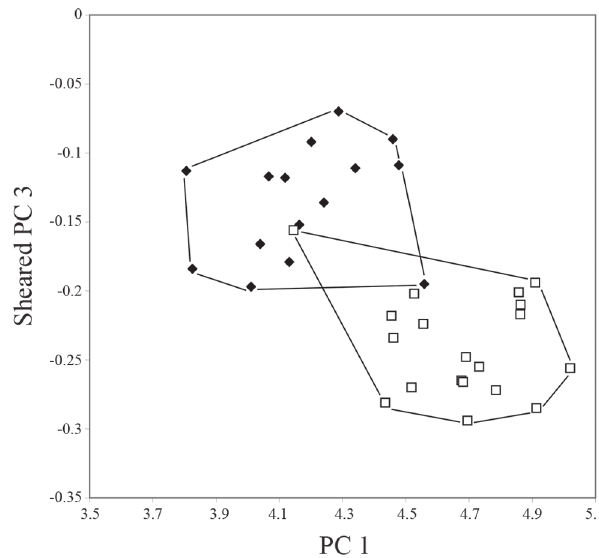
Fig. 4. Projection of the individual scores obtained through the analysis of the Principal Components of the combined samples of Pimelodella with 2n = 46 (diamonds) and with 2n = 52